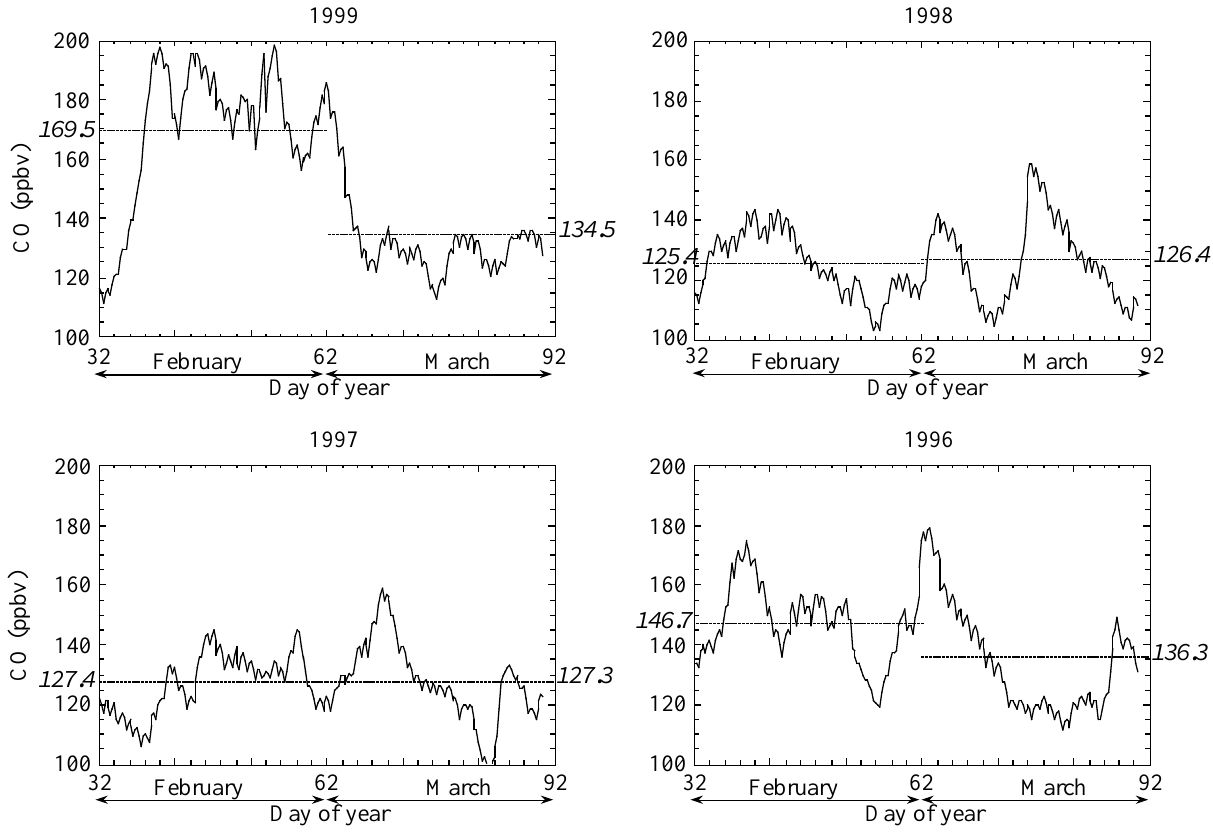
Fig. 34. Surface CO mixing ratio (ppbv) south of India at 5.5 ◦ N, 77 ◦ E, for February and March 1999, 1998, 1997, and 1996, calculated with the ECHAM4 chemistry-general circulation model. The straight lines represent the monthly averaged modelled CO mixing ratios (from de Laat and Lelieveld, 2002, copyright 2002 by the American Geophysical Union, reproduced with